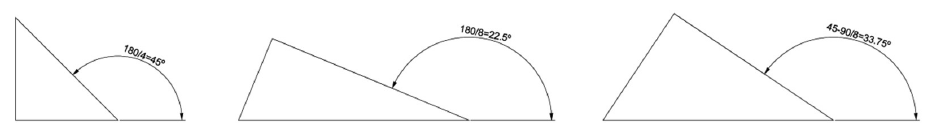
Figure 5. Bevels to trace the eight-point star, according to López de Arenas (1633). Authors’ own drawing, 2020.